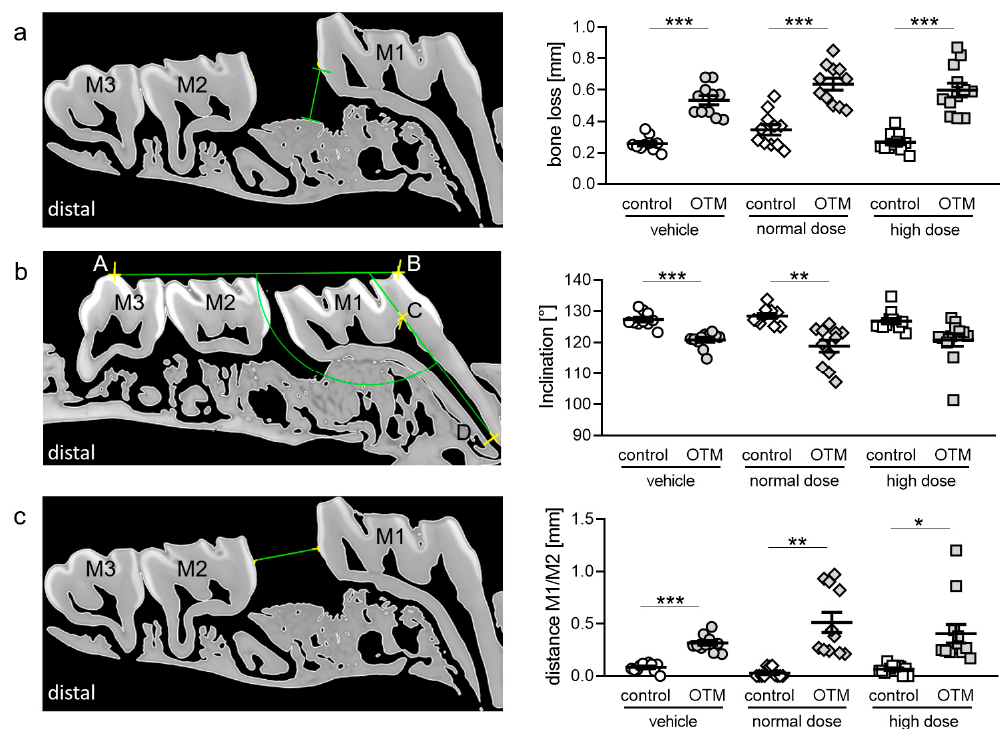
Figure 4. ( a ) Periodontal bone loss, ( b ) molar inclination (M1) and ( c ) distance between M1 and M2; measured using micro-computed tomography (µCT). n ≥ 10. Statistics: ( a ) Ordinary ANOVA followed by Bonferroni multiple comparison tests ( b , c ) Welch-corrected ANOVA followed by Games–Howell multiple comparison tests. * p < 0.05; ** p < 0.01; *** p < 0.001.